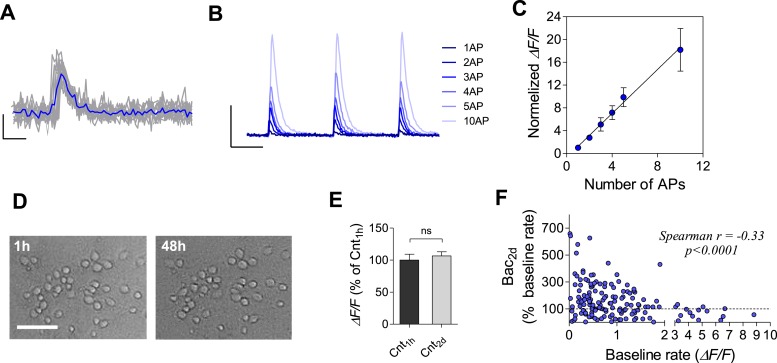
Calcium imaging using GCaMP6f sensor in cultured hippocampal neurons.(A) Fluorescence change in response to one action potential (AP). Single sweeps (grey) and averages of 10 sweeps (blue) are overlaid. Scale bars: 10% ΔF/F, 500 ms. (B) Fluorescence change (average of 10 sweeps) in response to 1—10 APs (3 trials). Scale bars: 200% ΔF/F, 2 s. (C) Peak fluorescence change as a function of number of APs (normalized to the peak fluorescence changed induced by 1 AP). A linear relationship between ΔF/F and number of APs (slope of linear fit is 1.928 ± 0.078, r2 = 0.99, n = 5). Recurrent activity was suppressed with 20 µM DNQX and 50 µM AP5 in (A–B). (D) Example of cultured neurons before and 2 days following baclofen incubation show no notable change in cell appearance. Scale bar: 50 µm. (E) Baseline firing rates 1 hr and after 2 days of control recording show stability with no evidence of phototoxicity (62 neurons). (F) Per unit correlation between baseline ΔF/F mean rates and the percent change in ΔF/F rates after 2 days in the presence of baclofen showing significant negative correlation (Spearman r = −0.33, p < 0.0001, 192 neurons).